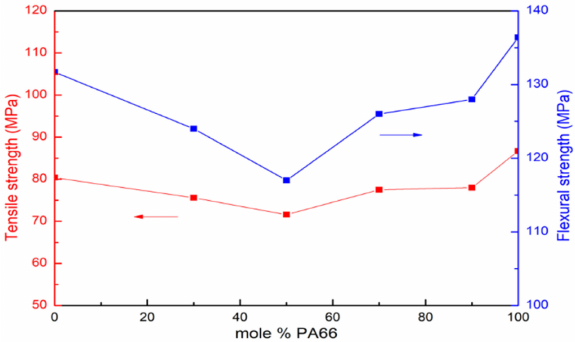
Figure 6. The tensile strength and flexural strength of PA56/66 copolyamides.